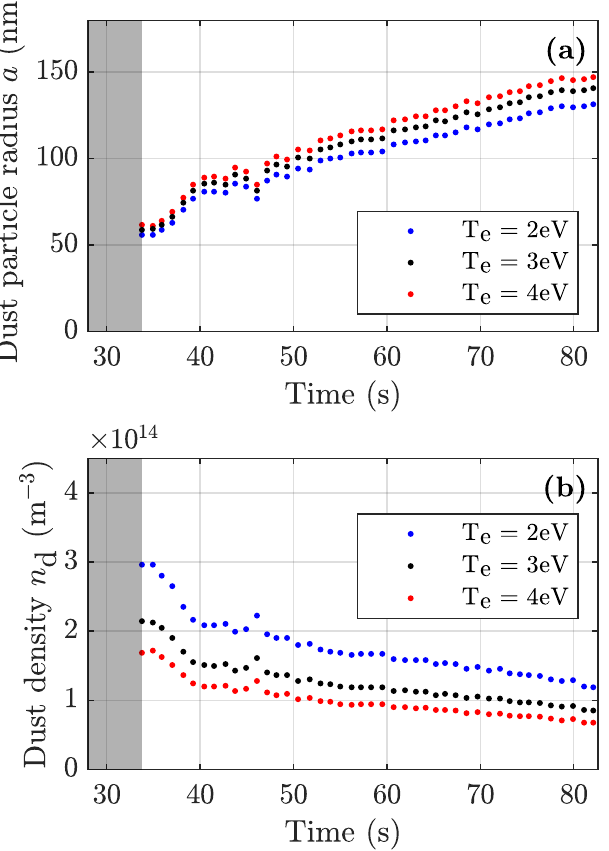
Figure 6. Sensitivity analysis for the electron temperature. Using the same raw data set, the dust particle radius (shown in panel ( a )) and dust density (shown in panel ( b )) are determined for an electron temperature ranging between T e = 2–4 eV, while a constant value of the negative ion density n i − = 4 n e,initial is